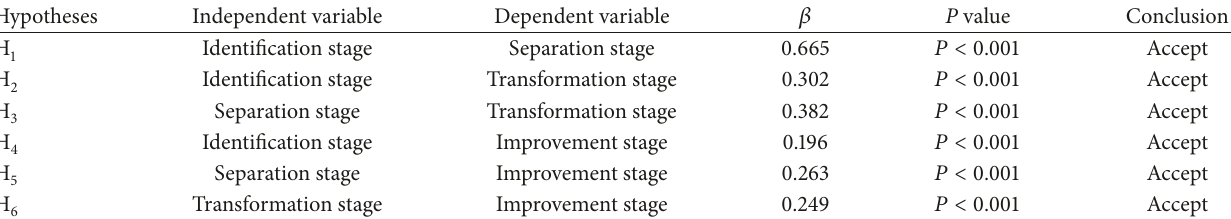
Table 6: Hypotheses validation.